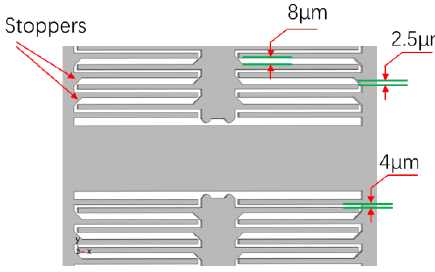
Figure 2. Stoppers located on electrodes.